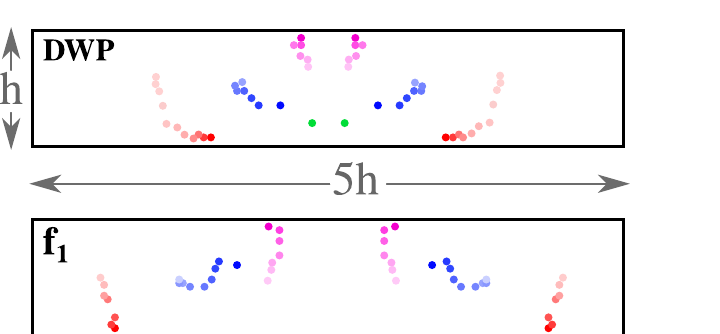
Figure 5. Local dynamics of the vortical centers from inlet to outlet for the initial DWP design and the optimized design obtained using a TPF Morph objective function f 1 (see Eqs. 4, 9). The colour intensity of the vortical centres decreases progressively as going in the stream directly from the inlet to the